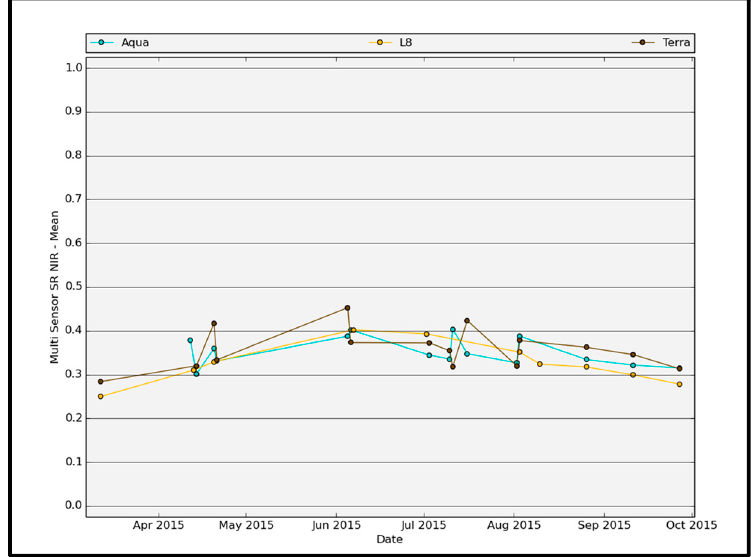
Figure 9. Mean near-IR (NIR) Terra and Aqua MODIS, and Landsat 8 surface reflectance values for scenes selected for Grand Marin.